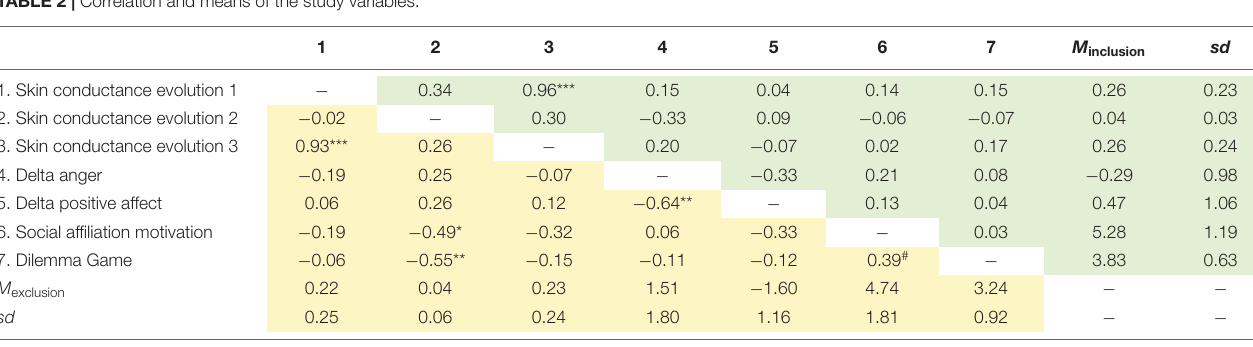
Frontiers in Psychology |